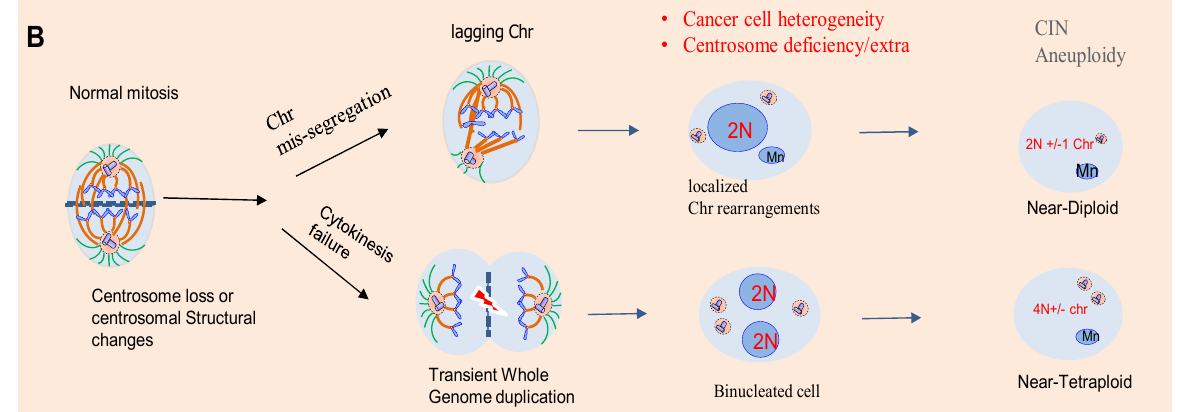
Figure 1. The route to aneuploidy and its link to centrosome dysfunction. ( A ) Aneuploidy is caused by errors in chromosome partitioning during mitosis. Changes include whole chromosomes (numerical aneuploidy) often caused by altered expression or mutations in centrosome (i.e., CEP55) and cytokinesis (i.e., PRC1) regulators [8]. ( B ) Centrosome loss or structural changes in its components are early drivers of genomic instability causing both localized chromosome rearrangements and transient tetraploidy [18]. These alterations will generate intra-tumor heterogeneity and tumors containing a mix of cells with extra-numerical centrosomes or loss of its components. In general, little is known about the mechanisms of centrosome loss. However, centrosomes are normally inactivated or lost during specific developmental stages in different animals. Abbreviations: Chromosome, Chr; CIN; Chromosome instability.